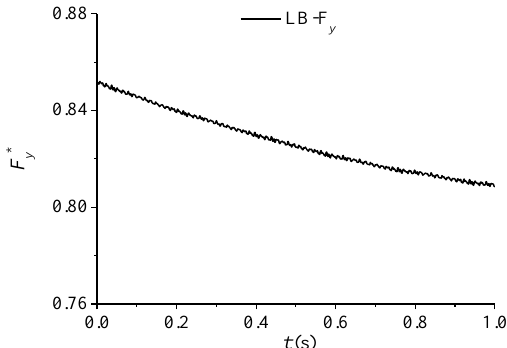
Figure 17. The axial water thrust of the runner lower band.